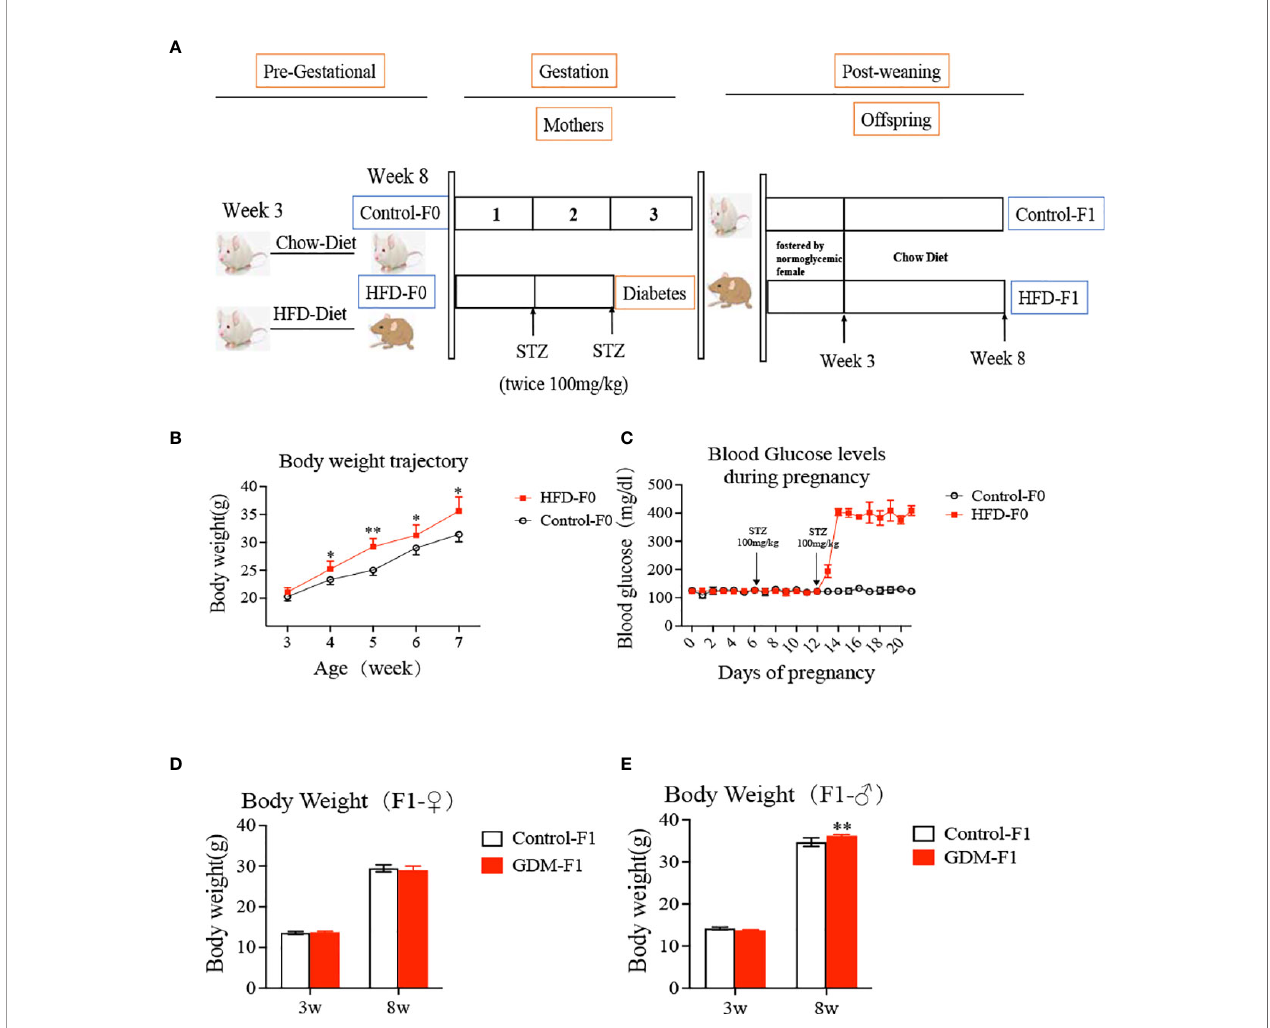
FIGURE 1 | Experimental design, offspring growth curves. (A) Experimental design; the ICR female mice (age 3-4 weeks) divided into two group, fed with a high-fat diet or chow diet for 4 weeks. Then the mice were mated with nonnal ICR males. The pregnancy ICR females were injected STZ or citrate buffer on day 6 and day 12 of pregnancy. Both the control and GDM pups were fostered by normoglycemic female until they were three weeks old, and then fed by chow diet. (B) body weight of mice both fed by high fat diet or chow diet at different developmental weeks; (C) Blood glucose levels during pregnancy for mice both fed by high fat diet or chow diet; (D) Body weight of female F1 offspring; (E) Body weight of male F1 offspring. In all panels, data are presented as mean ± SD, * P < 0.05. ** P < 0.01, n = 6 mice per group. Signi fi cance was determined by Student t